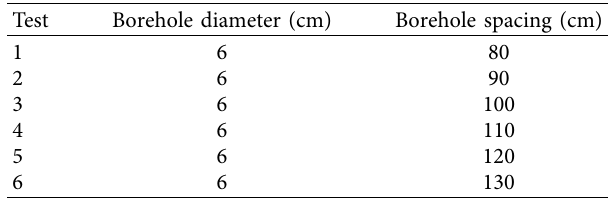
Figure 17: Stress diagram under double-hole loading. Table 4: Parameters of the